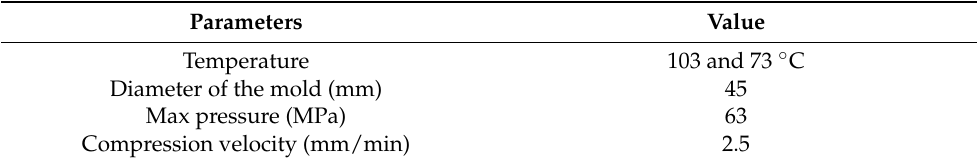
Table 2. Values of research parameters.